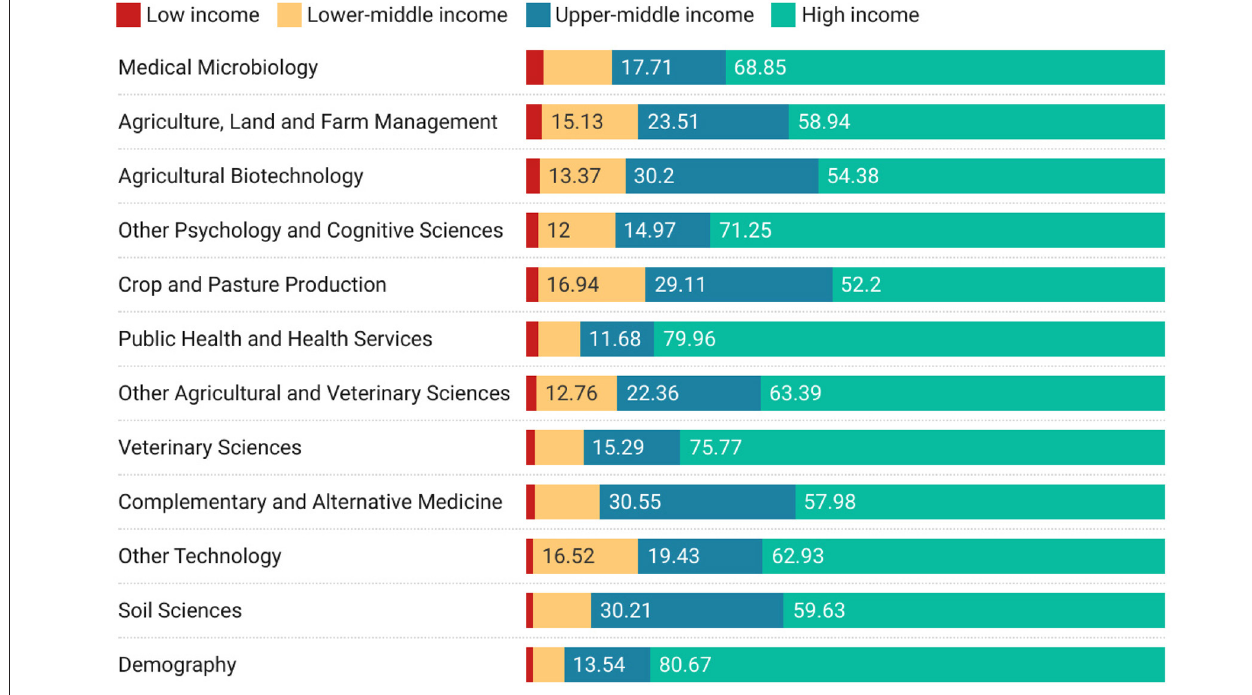
merely a choice not to work together (even on items of